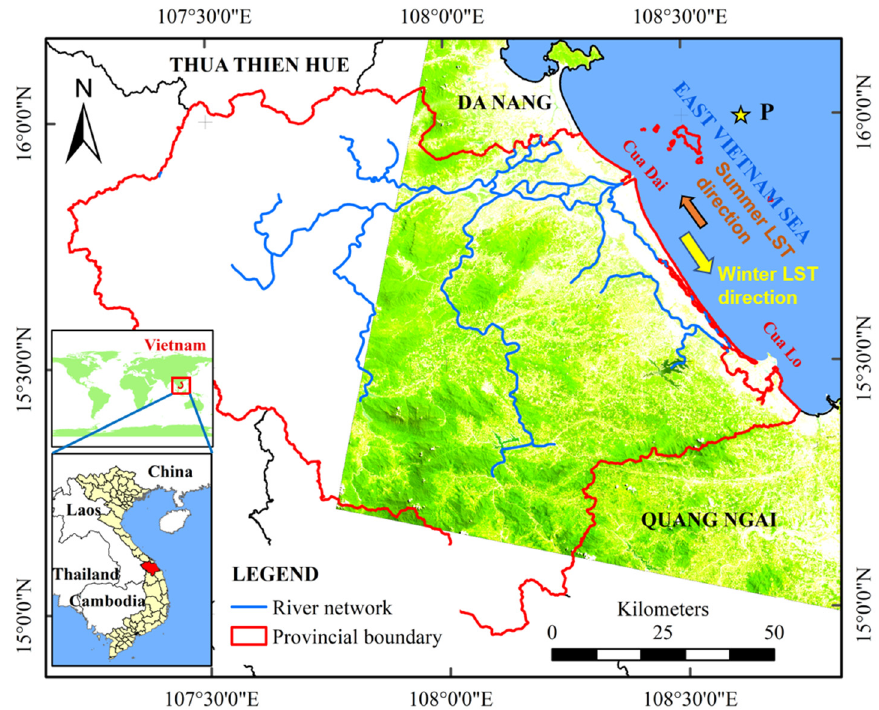
Figure 1. Location of the study area with an overlapped Landsat scene on 9 September, 2019 (source: https://earthexplorer.usgs.gov/, accessed on 8 July 2021).